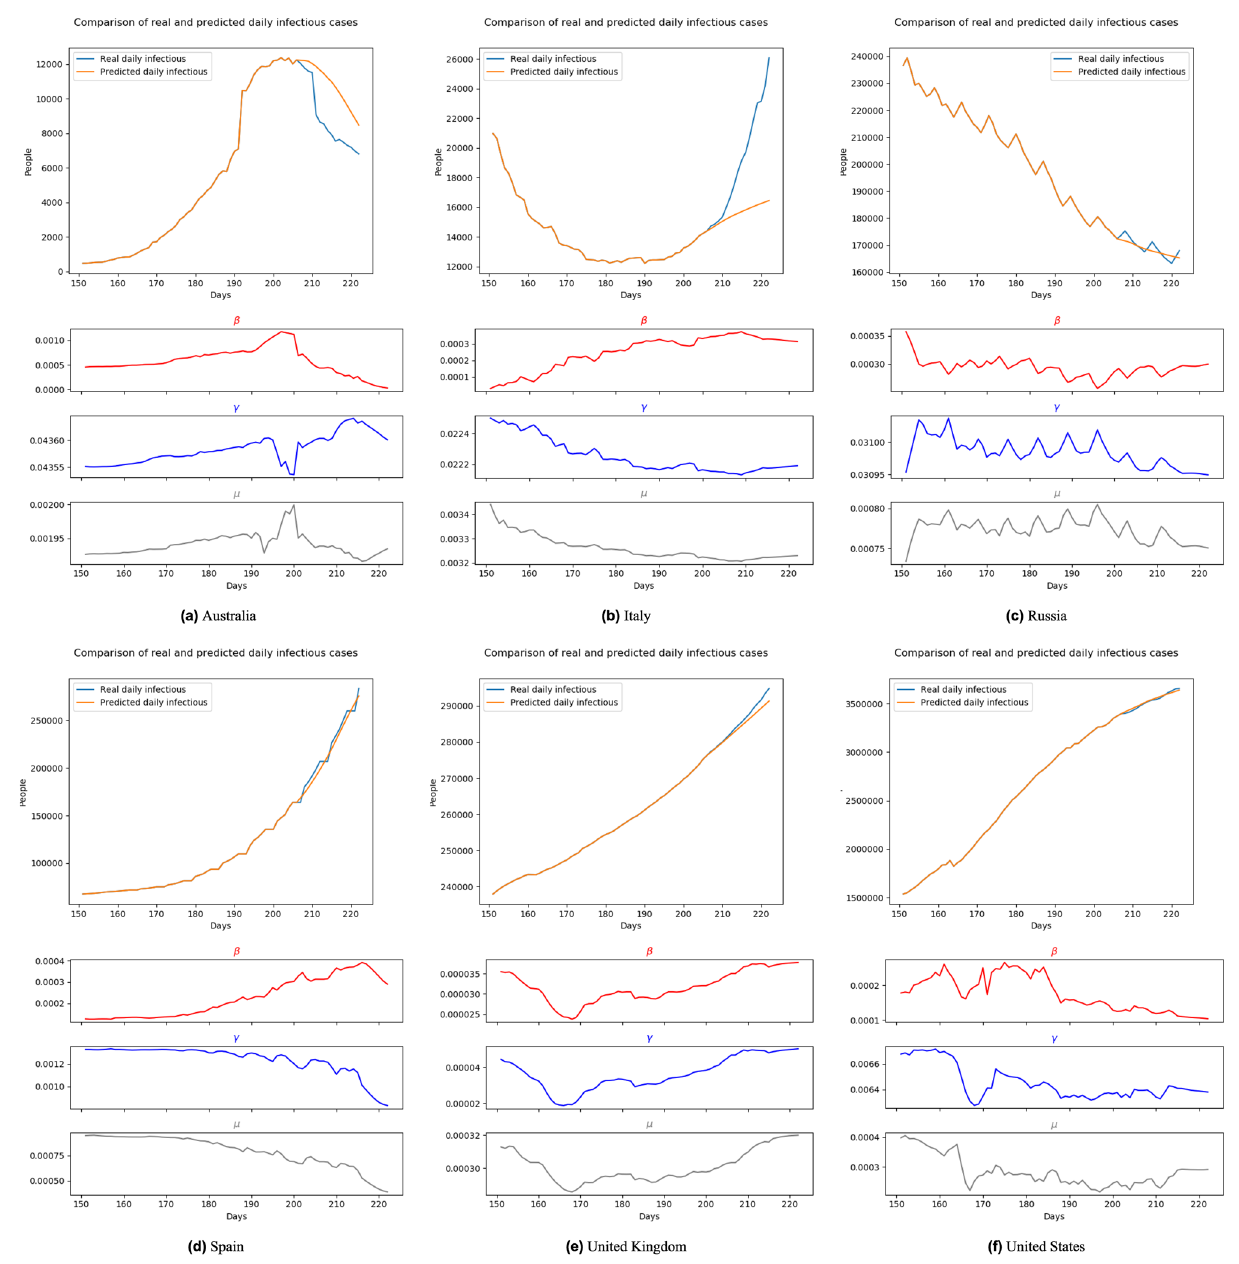
Figure 13. Forecasting results with transition rates of 207th–222nd day (Aug. 16th 2020–Aug. 31st 2020) using data of 197th–206th day (Aug. 6th 2020–Aug. 15th